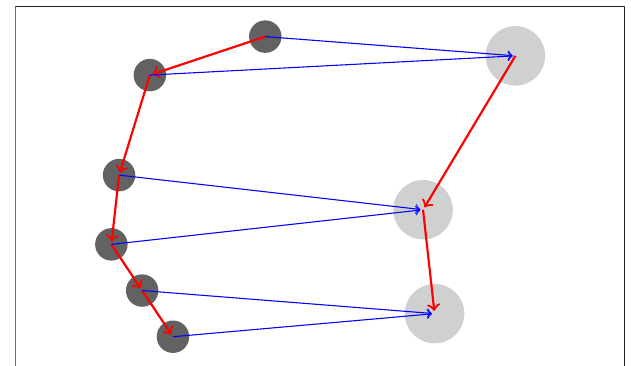
FIGURE 2 | Coarsening a protein. The features of each two residues in the chain (left graph) are averaged together and a new coarse graph is computed (right) for the coarse protein. The graph Laplacian is computed directly from the rediscretized coarse